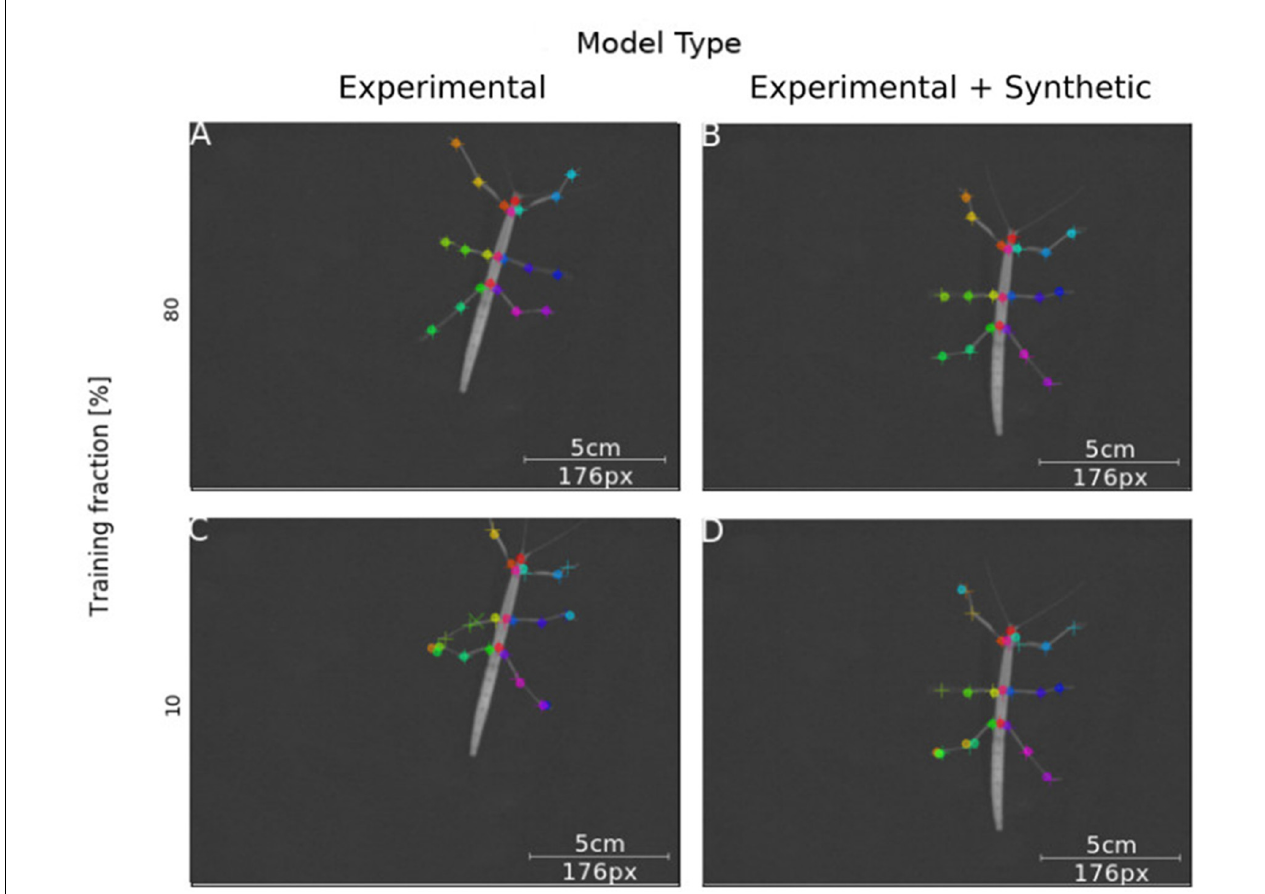
FIGURE 7 | Synthetic training data can lead to good model performance. Selected frames illustrate performance of model variants that do (Synthetic + Experimental, right panels) or do not (Experimental-only, left panels) include artificially generated frames, and differ in the fraction of training data (top panel: 80% of frames were annotated for training; bottom panel: Only 10% of frames were annotated). Circles mark the position of high-confidence estimates of the network, crosses mark low confidence estimates; + symbols mark manually annotated positions. (A) The Experimental-only model with a training fraction of 80% achieved good performance (no mis-locations). (B) The Synthetic + Experimental model with 80% training fraction achieved similarly good performance as (A) . (C) The Experimental-only model with 10% training fraction showed some errors and low-confidence estimates. (D) The Synthetic + Experimental model with 10% training fraction shows several